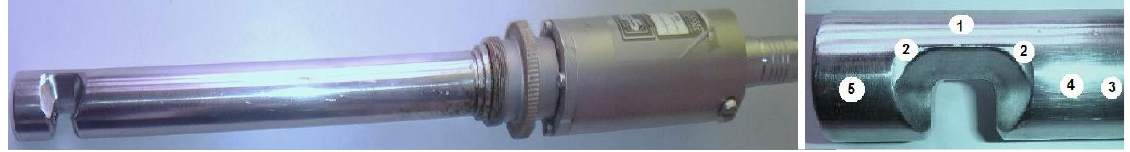
Figure 5. Optek sensor (http://www.optek.com/).